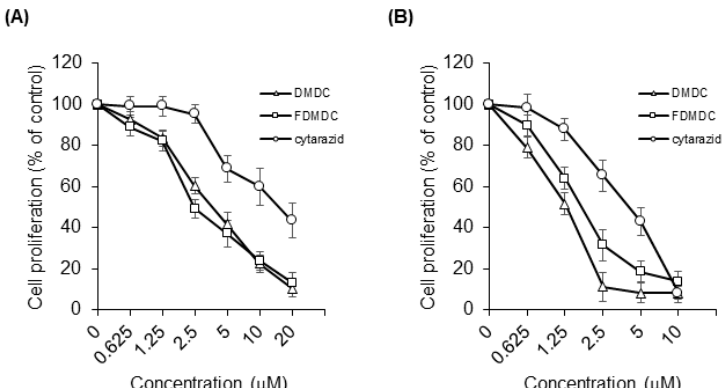
Figure 2. DMDC, FDMDC, and cytarazid inhibited cell growth of ATL cell lines and HTLV-I- transformed cell lines in vitro. TL-OmI cell lines ( A ) and MT-2 cell lines ( B ) were seeded at a density of 2 × 10 4 cells in the presence of various concentrations of nucleosides DMDC, FDMDC, and cytarazid for 72 h at 37 °C. The cells were further incubated with the Cell Proliferation Reagent WST-1 for 2–4 h at 37 °C. For ( A ) and ( B ), bars indicate mean values ± standard error of the mean (n = 3). The half-maximal inhibitory concentration (IC 50 ) values of DMDC, FDMDC, and cytarazid in tested